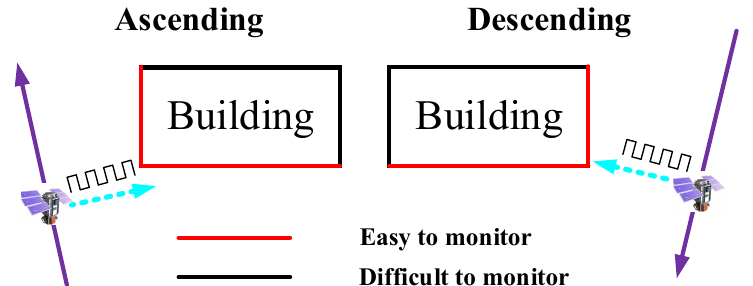
Figure 21. The illustration of building information which could be monitored by InSAR.